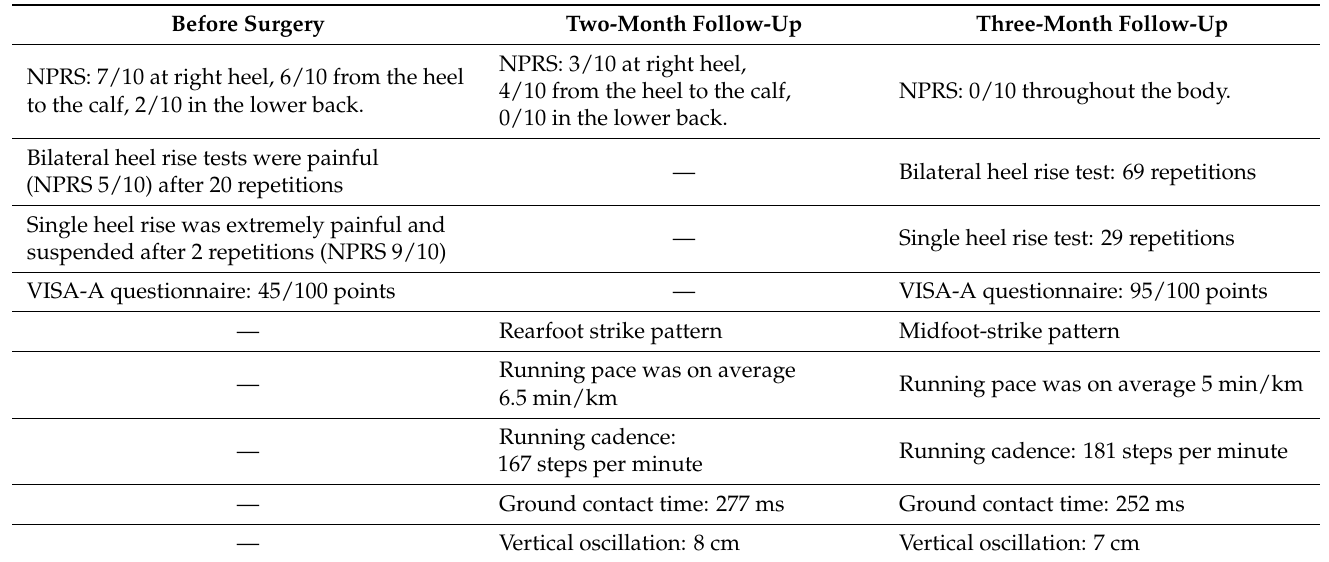
Table 1. Outcome and